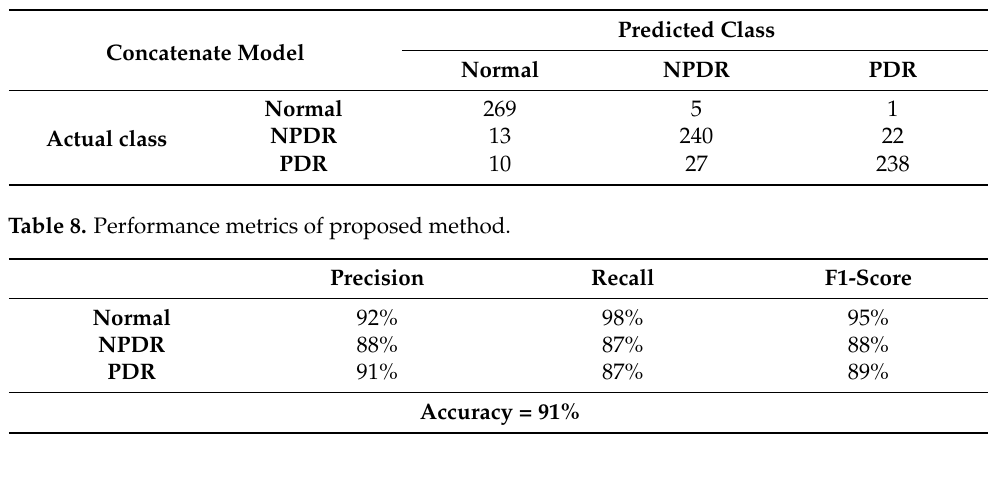
Table 7. The confusion matrix of proposed method.